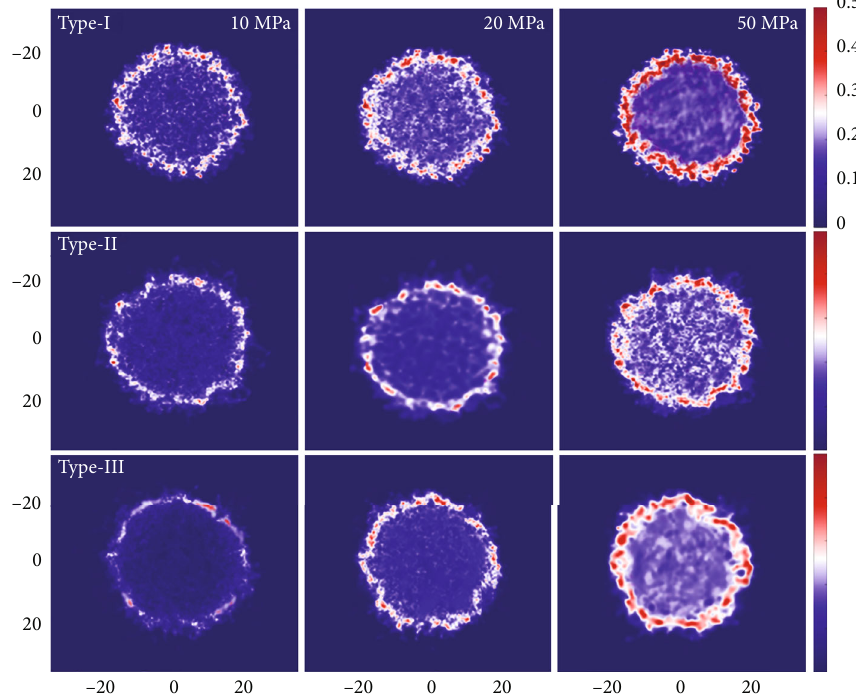
Figure 5: CH density distribution in 4nm shale organic nanopore under di ff erent pressure 4